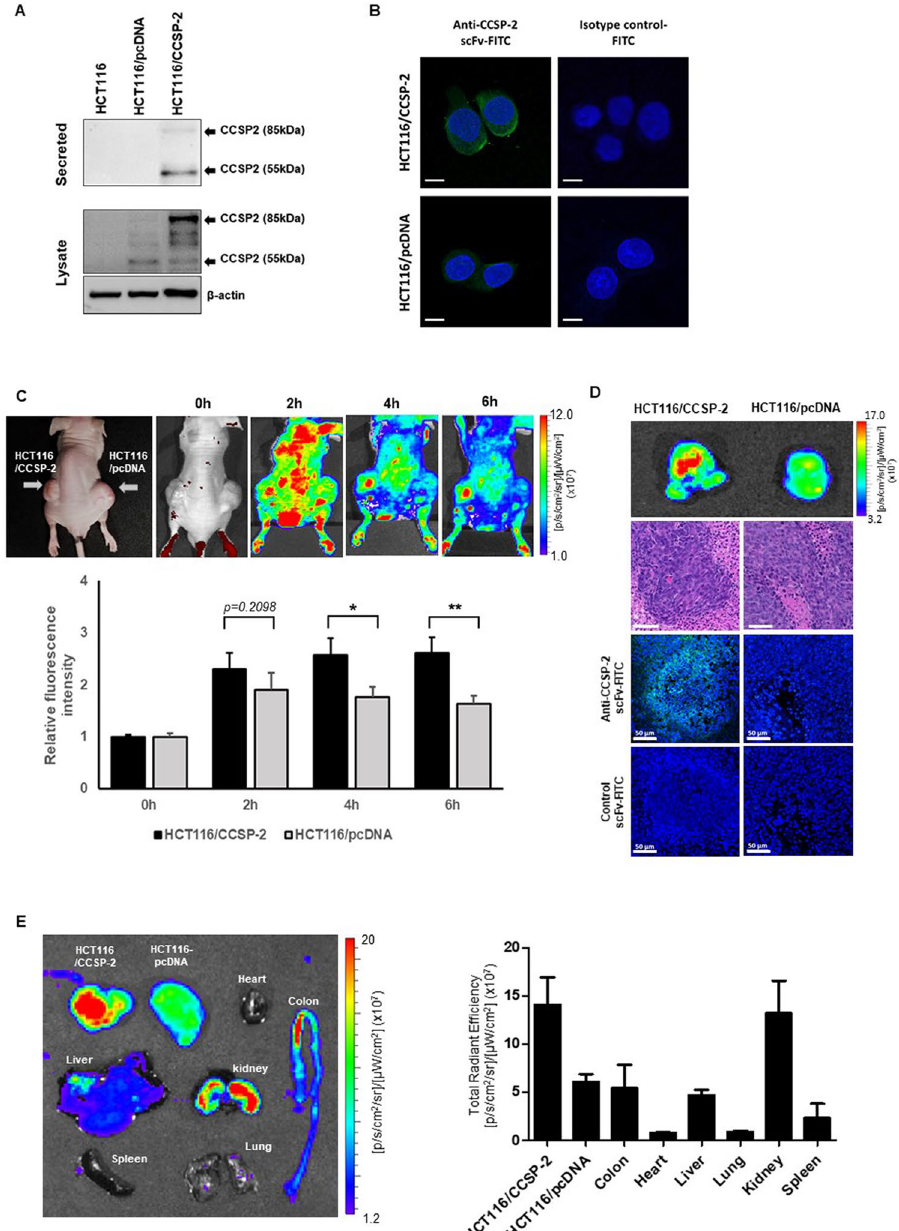
Figure 2. Molecular imaging of CCSP-2 probe binding in vitro and in vivo. ( A ) Western blot analysis of CCSP-2 in HCT116 cells transfected with a CCSP-2-encoding plasmid. ( B ) In vitro confocal images of CCSP-2- overexpressing HCT116 cells and control vector-transfected HCT116 cells treated with FITC-conjugated anti- CCSP-2 scFv. FITC-conjugated kappa isotype control antibody was used as the negative control (magnification: ×630, scale bar: 10 μm). ( C ) In vivo molecular images of CCSP-2-overexpressing xenograft tumor-bearing mice after the tail vein injection of anti-CCSP-2 scFv-FITC. Data shown are the mean ± SD of at least three independent experiments ( *p < 0.05, **p < 0.01, n = 6). ( D ) Isolated solid tumors acquired from sacrificed mice to examine the fluorescence intensity ex vivo (top) and representative histological and immunofluorescence staining of xenograft tumors (original magnification: ×200, scale bar: 50 μm). ( E ) Ex vivo biodistribution analysis by fluorescence intensity. Organs were removed from anti-CCSP-2 scFv-FITC-injected mice after 8 h (n =